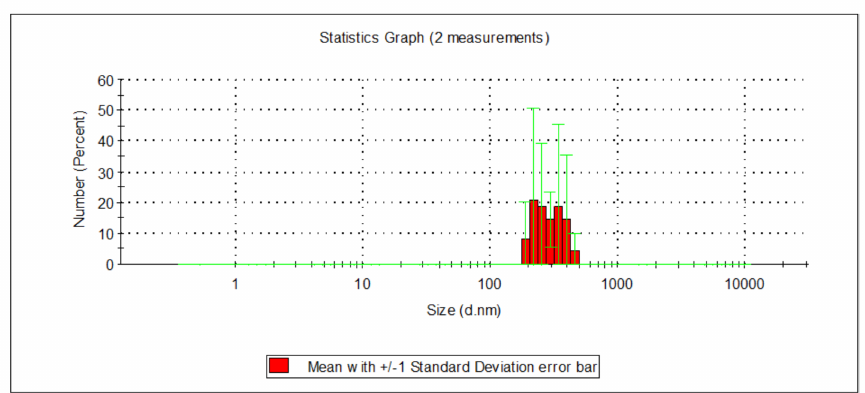
Figure 1. Distribution of particle sizes in mixed